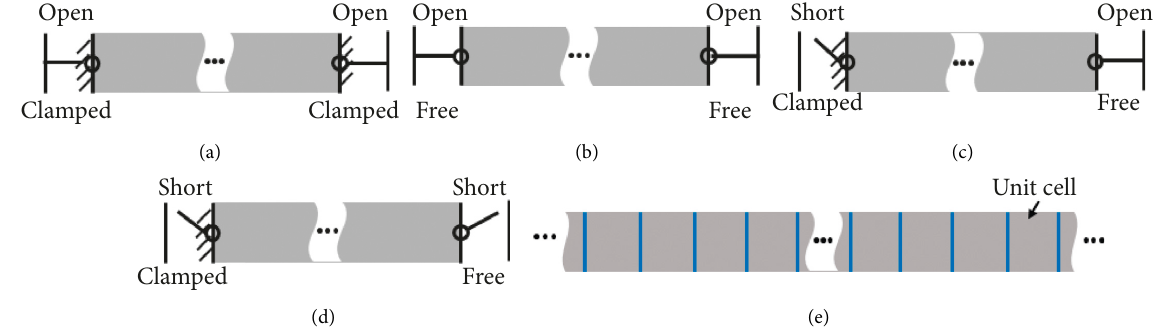
Figure 2: Schematic diagram of the structure for five types of typical boundary conditions, where (a) Case (I) COO-COO, (b) Case II: FOO- FOO, (c) Case III: CSS-FOO, (d) Case IV: CSS-FSS, and (e) Case V: periodical